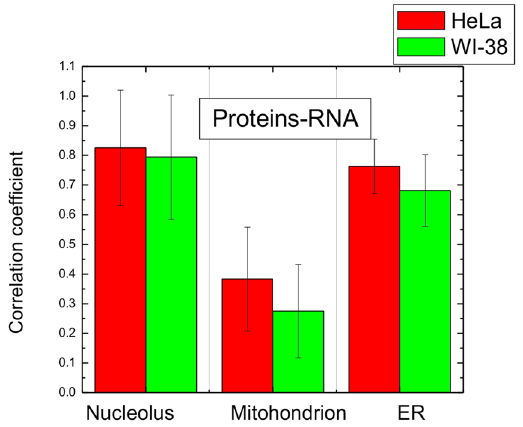
Figure 3. Pearson correlation coefficients between the concentrations of proteins and RNA of the same organelle - nucleoli, mitochondria and